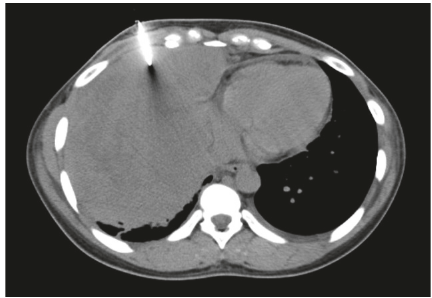
Figure 4: CT guided biopsy of